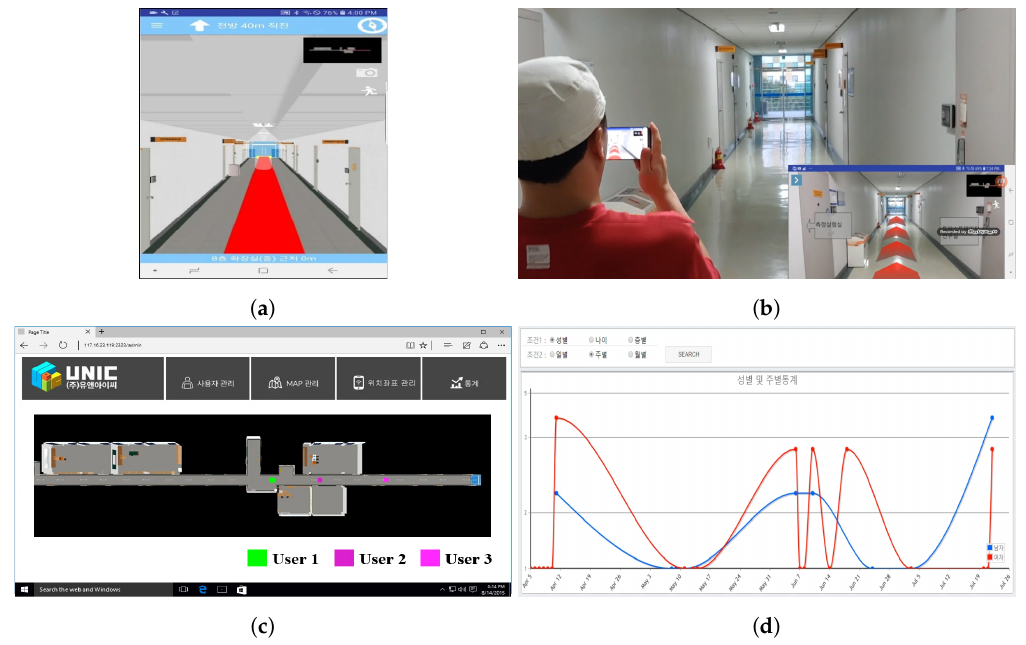
Figure 16. Indoor location-based services. ( a ) Indoor navigation service. ( b ) AR mode indoor navigation service. ( c ) Indoor monitoring service (people tracking). ( d ) Providing statistical data (people